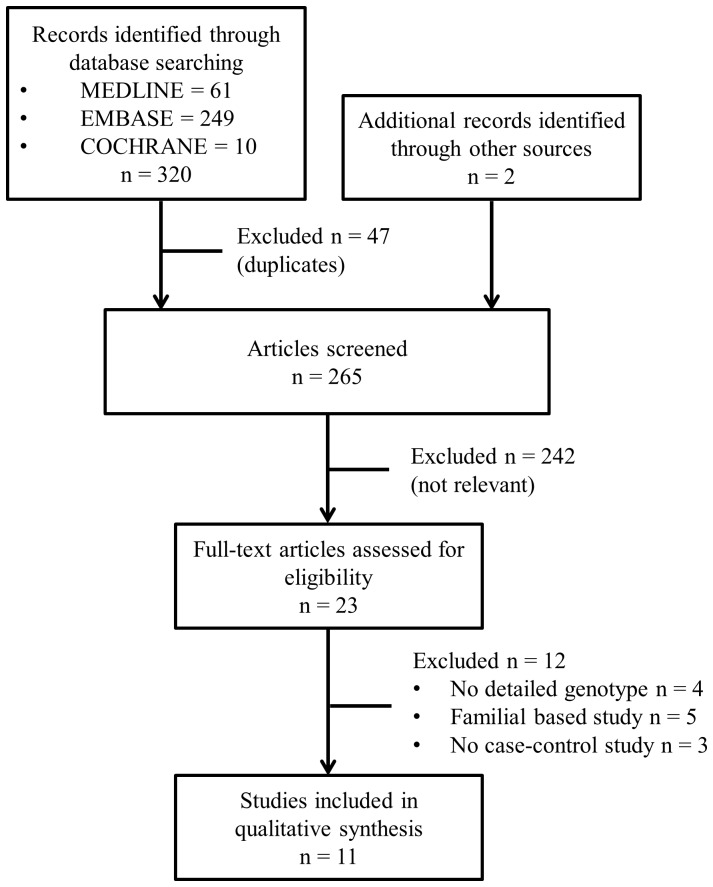
Study flow chart.